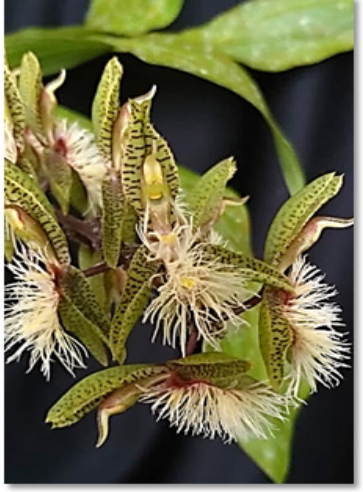
Figure 5. Catasetum barbatum (Source Luiz Otavio Adão) Synonimy: Catasetum barbatum var. spinosum Rolfe, C. brachybulbon Schltr., C. buchtienii Kraenzl., C. comosum Cogn., C. crinitum Linden, C. polydactylon Schltr., C. proboscideum Lindl., C. rionegrense Campacci & G.F. Carr, C. spinosum (Hook.) Lindl., C. variabile Barb. Rodr.,